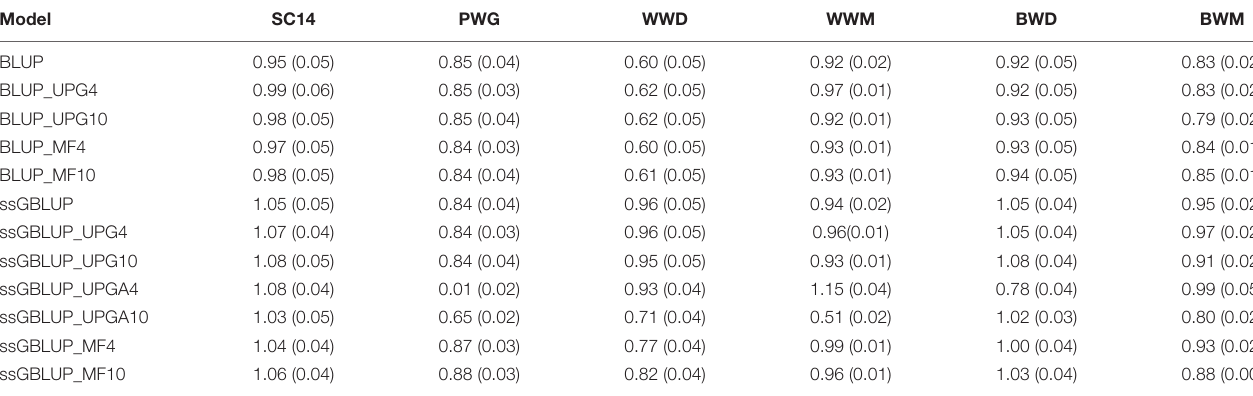
TABLE 5 | Regression coefficients of direct and maternal (G)EBV from the complete dataset on direct and maternal (G)EBV from the reduced dataset for validation animals and their standard errors (in parentheses) using various models with and without genetic groups.